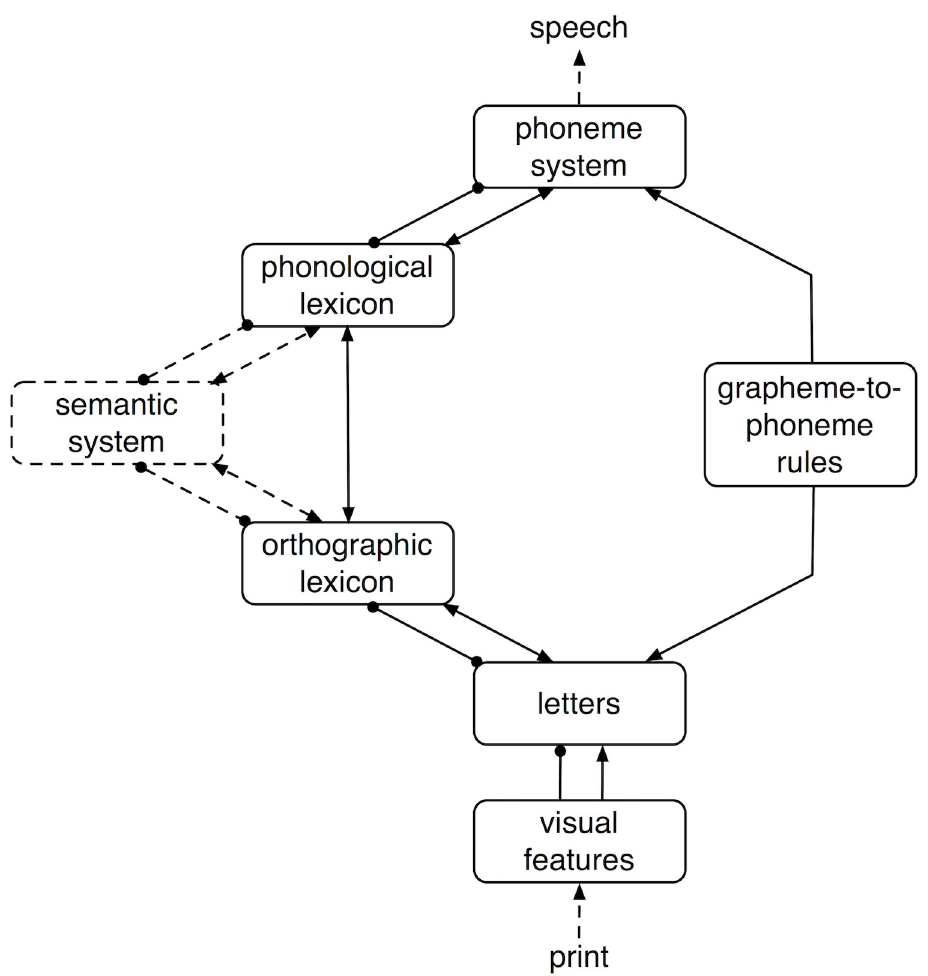
Fig 2. DRC model. Basic architecture of the Dual-Route Cascaded (DRC)